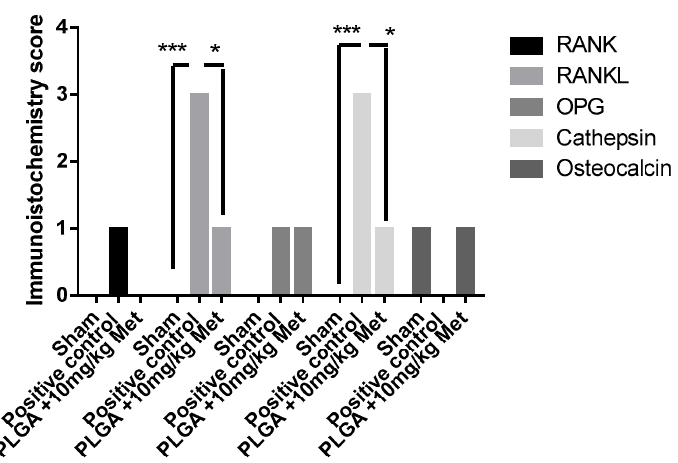
Figure 8. Immunohistochemistry score. Sham, positive control; PLGA + 10 mg/kg Met (* p < 0.05). (*** p < 0.001) (Kruskal–Wallis test followed by Dunn’s test).